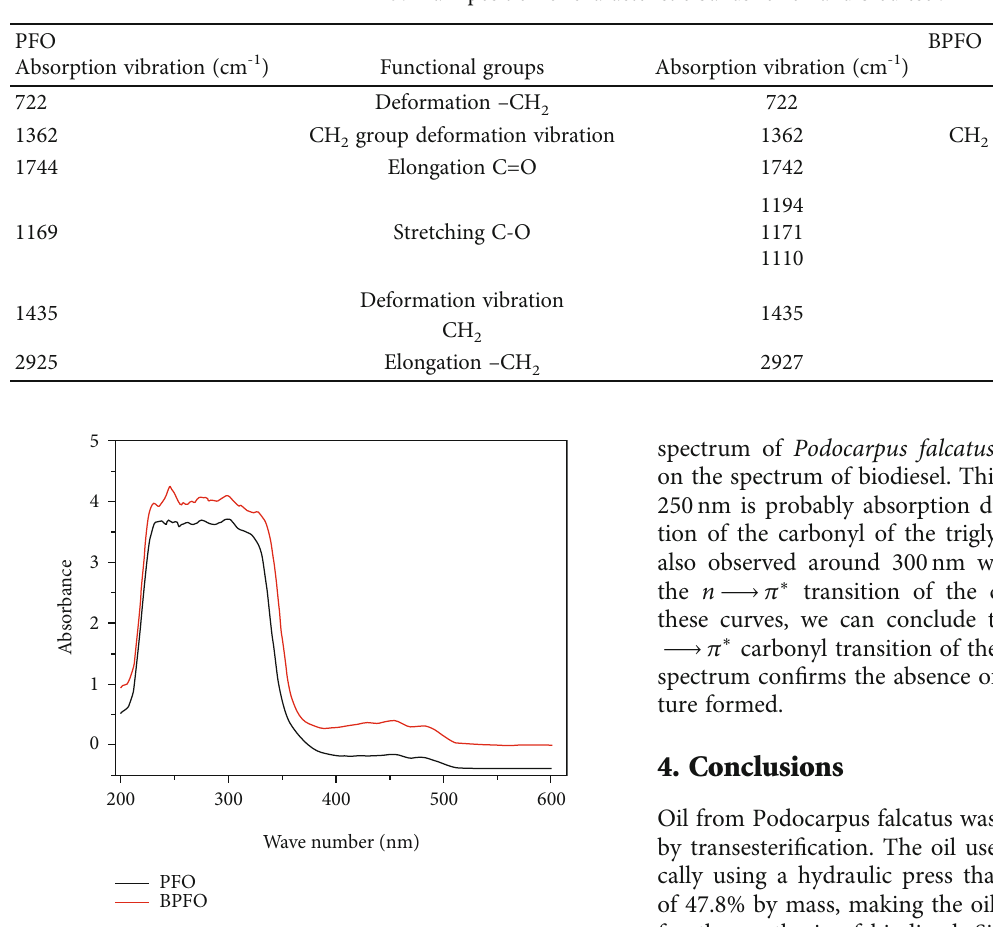
Table 7: Main position of characteristic bands for oil and biodiesel.